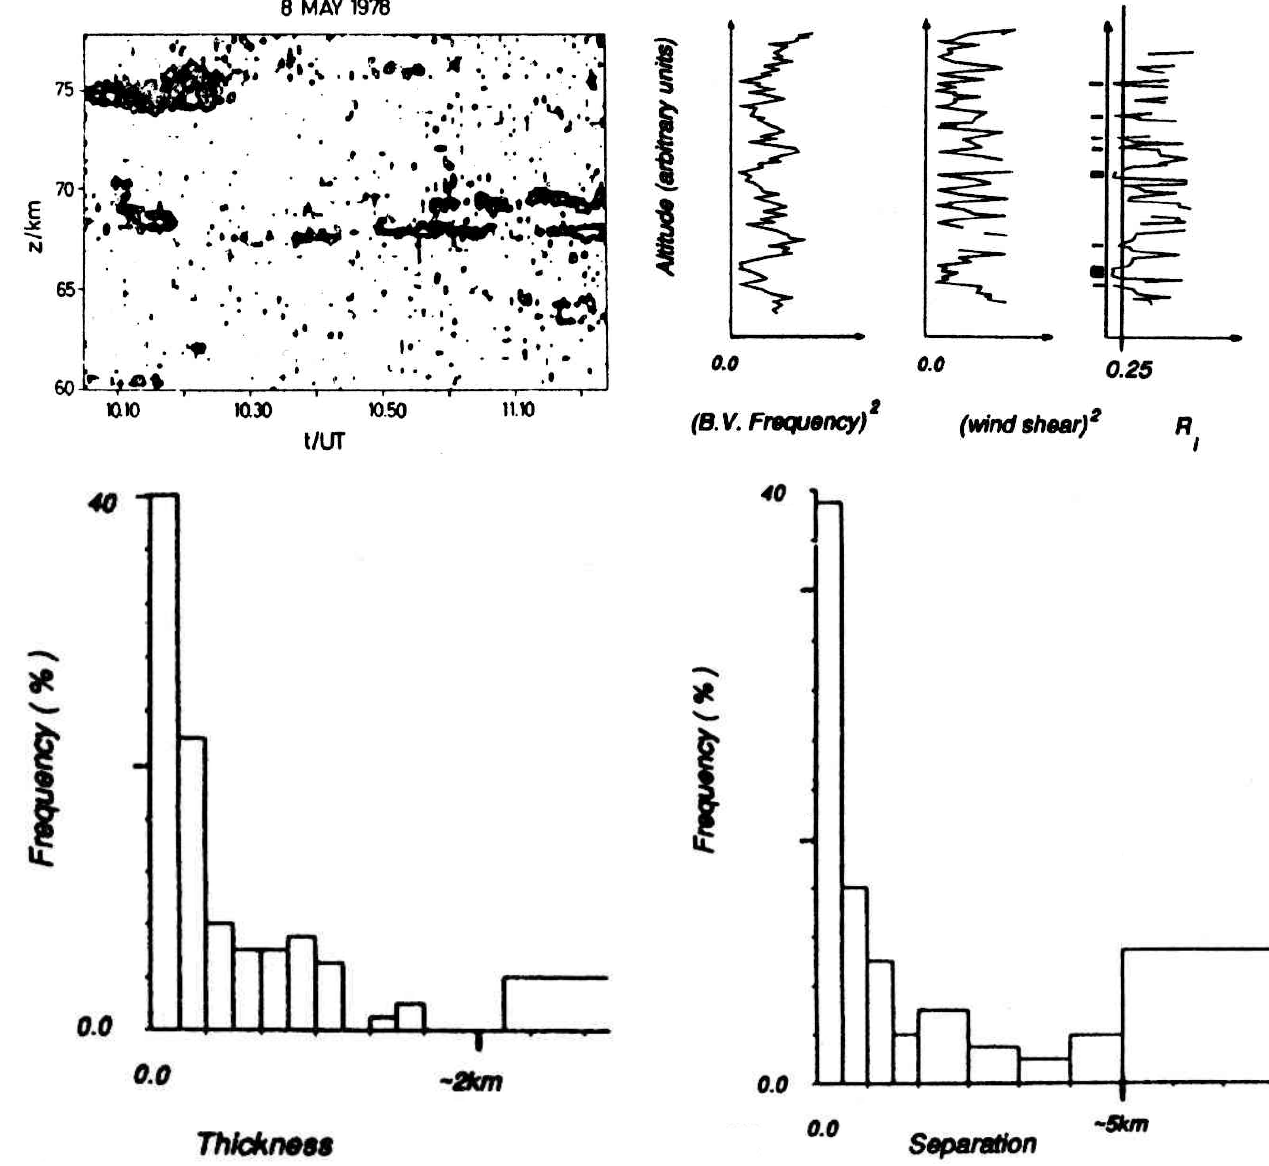
Fig. 2. (a) Another example of stratified radar echoes. (b) Typical profiles of Brunt-Vaisala frequency, wind shears, and resultant Richardson numbers, for a sample gravity wave field. (c) Distribution of the thicknesses of layers of turbulence expected in the stratosphere. Scales are only representative, and somewhat larger in the mesosphere than in the stratosphere. (d) Histogram of expected layer spacings. These figures have been adapted from Hocking